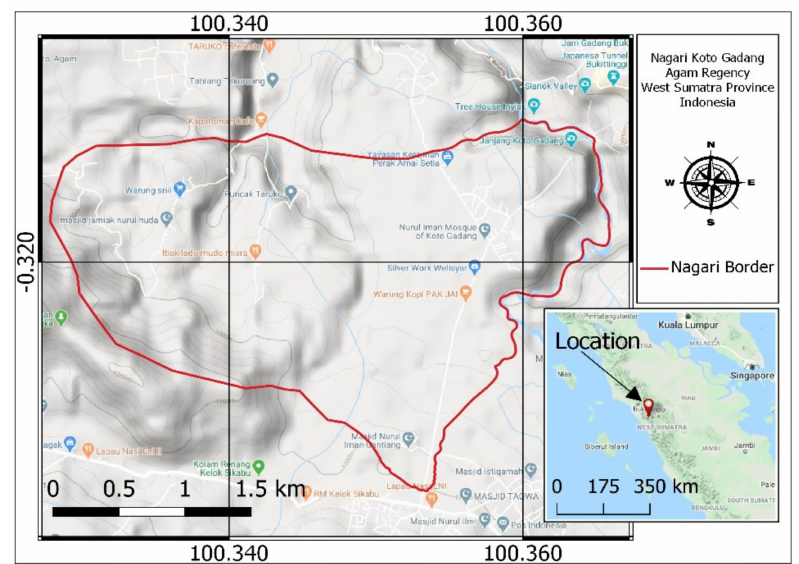
Figure 1. Map of the Koto Gadang customary village.